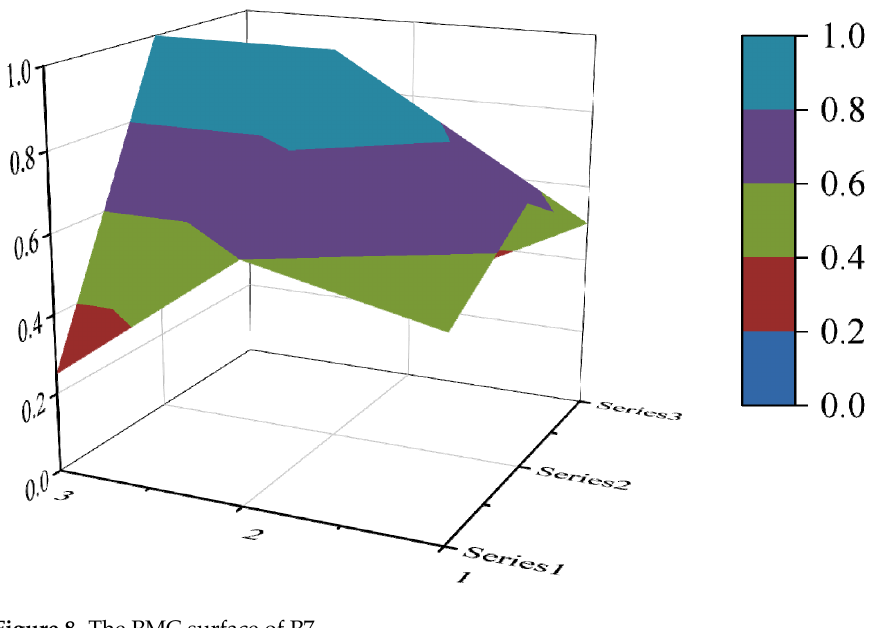
Figure 8. The PMC surface of P7.